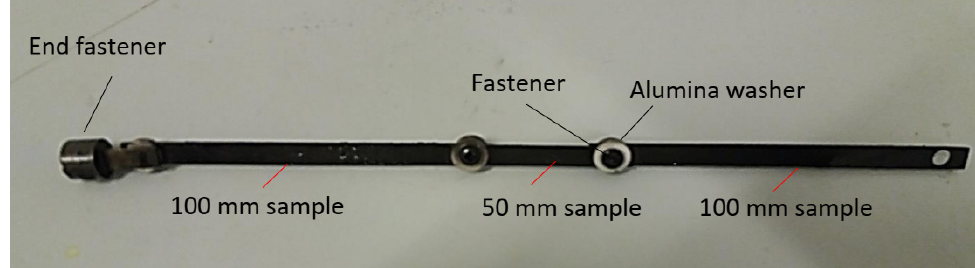
Figure 3. The carbon-steel samples in reactor 2 after the testing. All the carbon-steel samples in all three reactors had turned from shiny metal appearance to black appearance after the corrosion